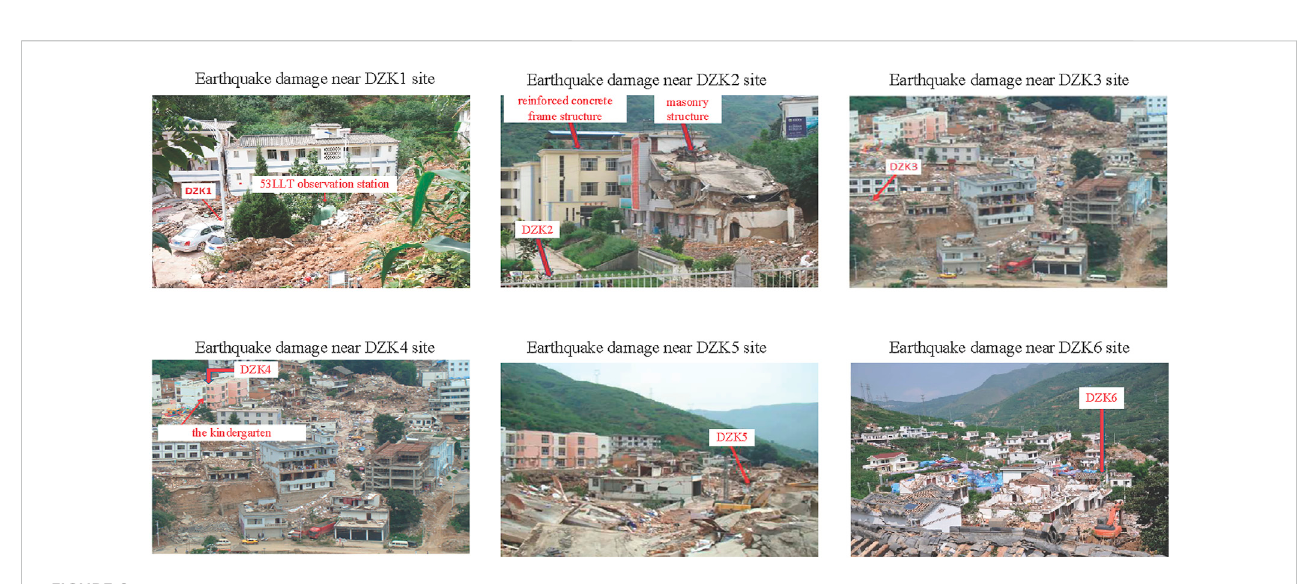
FIGURE 8 Earthquake damage in Longtoushan Market